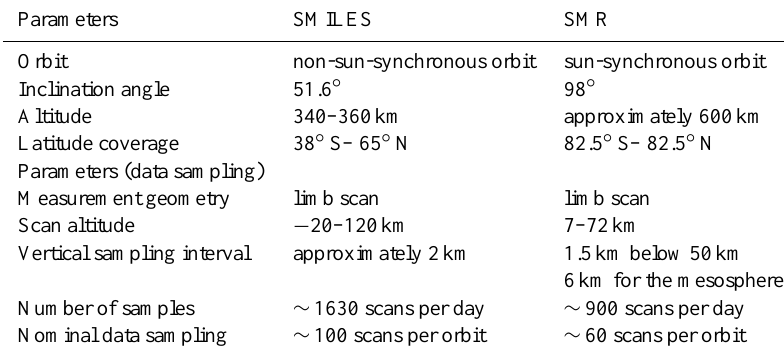
Table 1. Typical specification of the